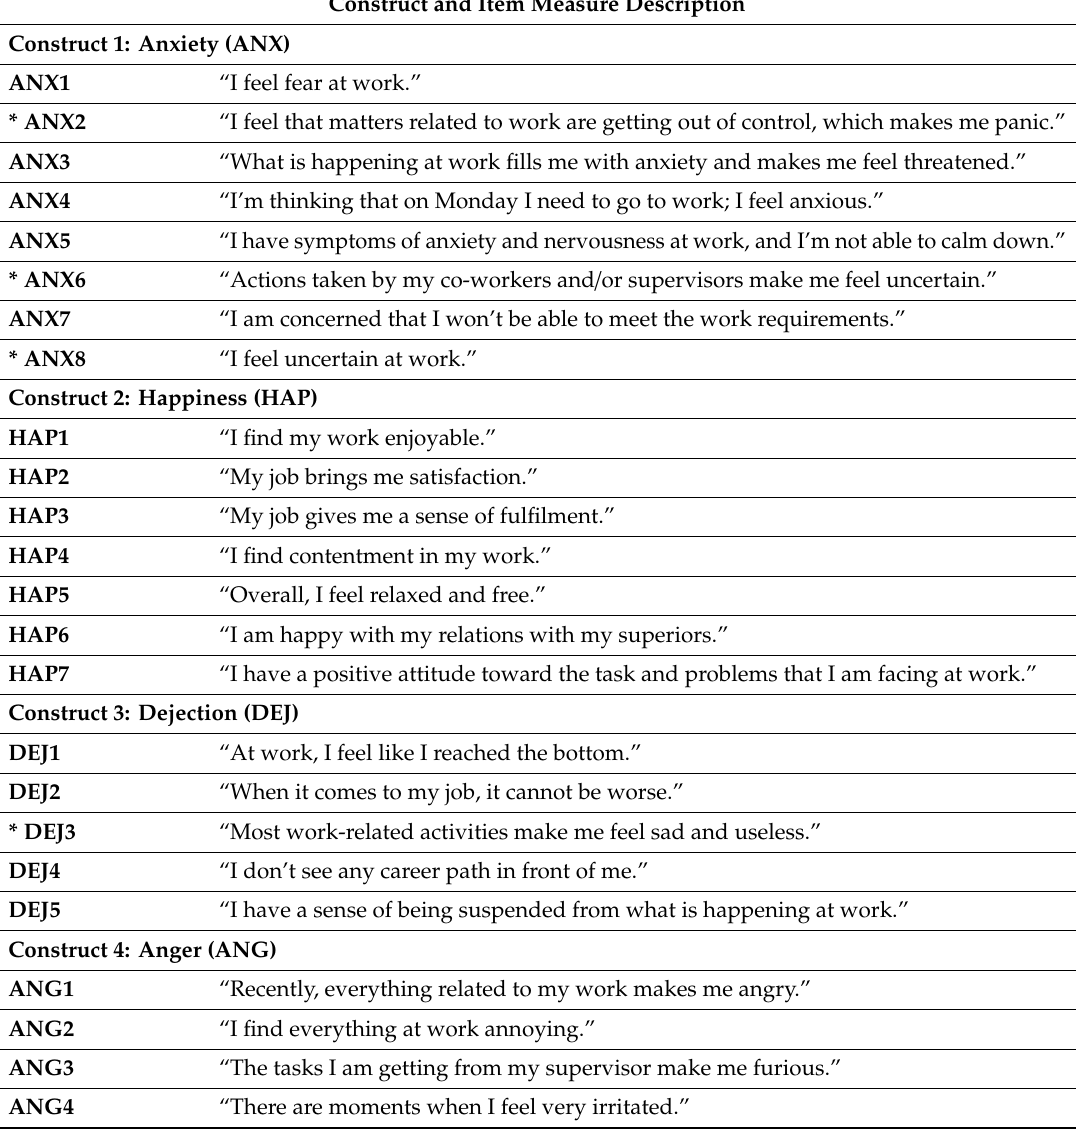
Table A1. Model constructs and their corresponding item measures